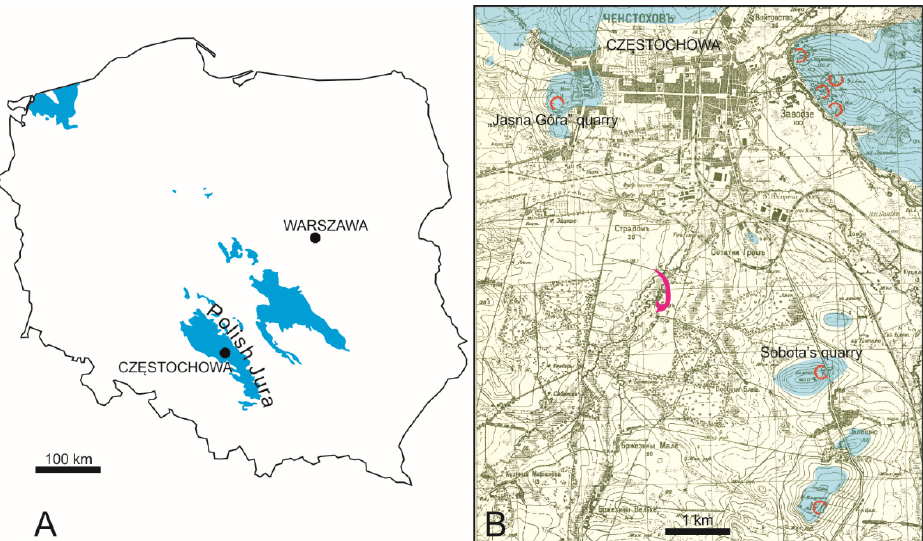
Figure 1. ( A ) Distribution of Jurassic deposits in Poland, with location of Cz ę stochowa. ( B ) Study site (marked by contour of onychite) and nearest outcrops of Oxfordian (blue) with quarries worked at the beginning of the 20th century (red). A map from 1913 is used as a background. Geologic data mainly from Ró ż ycki, 1953; map from Mapster (http://igrek.amzp.pl/, accessed on 10 October 2021).